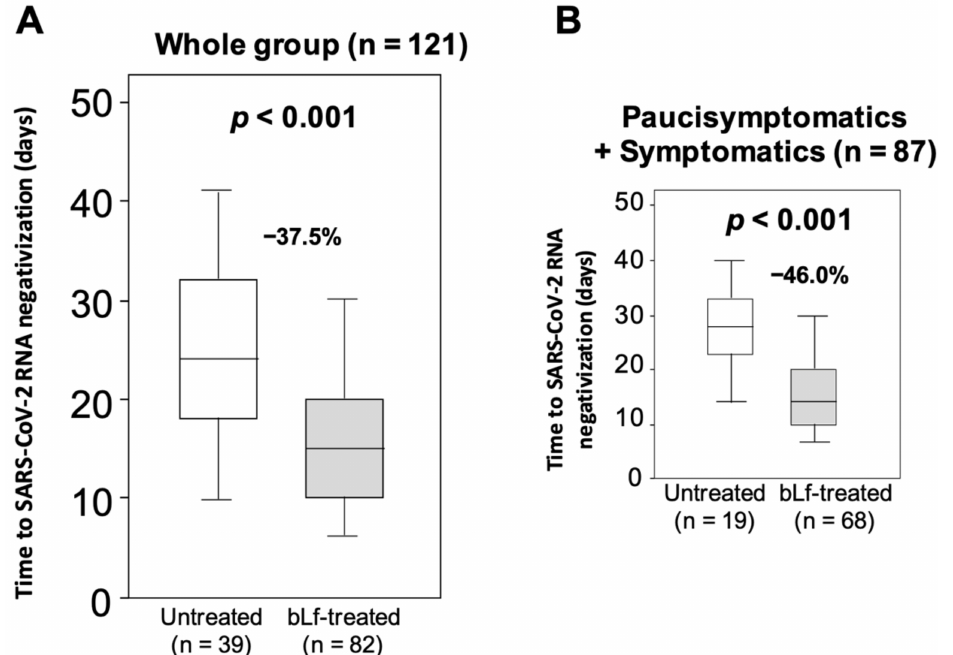
Figure 3. Box and Whisker plots of the days to SARS-CoV-2 RNA negativization in all bovine lactoferrin (bLf)-treated and untreated patients ( A ). The Box and Whisker plots are given in an analysis restricted to paucisymptomatic and moderate symptomatic patients ( B ). The ends of the box are the upper and lower quartiles. The median is indicated by the horizontal line inside the box. The 2.5th and the 97.5th percentile of the days to SARS-CoV-2 RNA negativization are also provided.